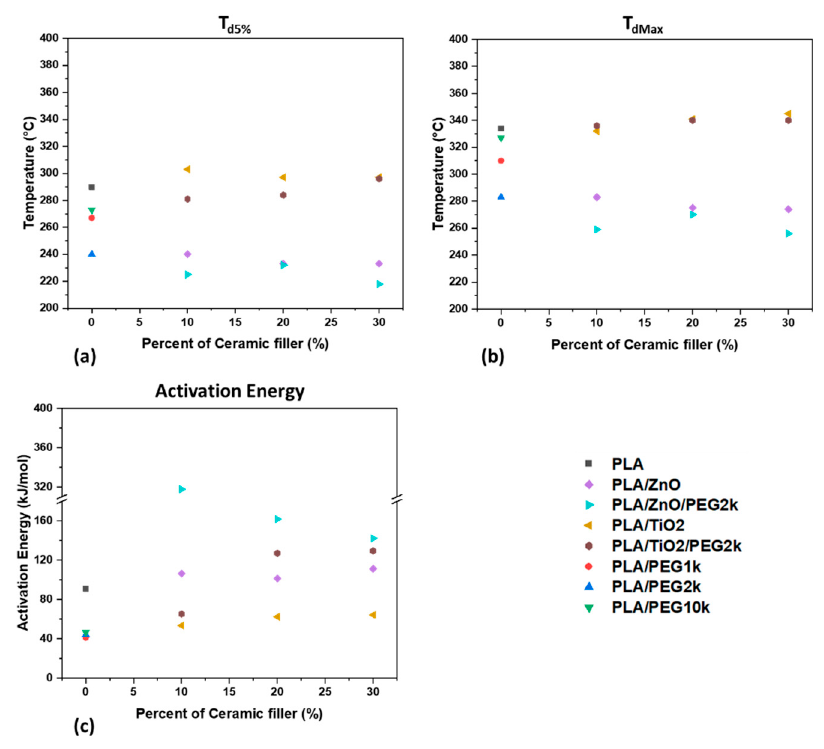
Figure 7. The thermal properties of the composite filaments: ( a ) the onset of thermal degradation ( T d5% ); ( b ) the decomposition temperature ( T dMax ); and ( c ) the activation energy.